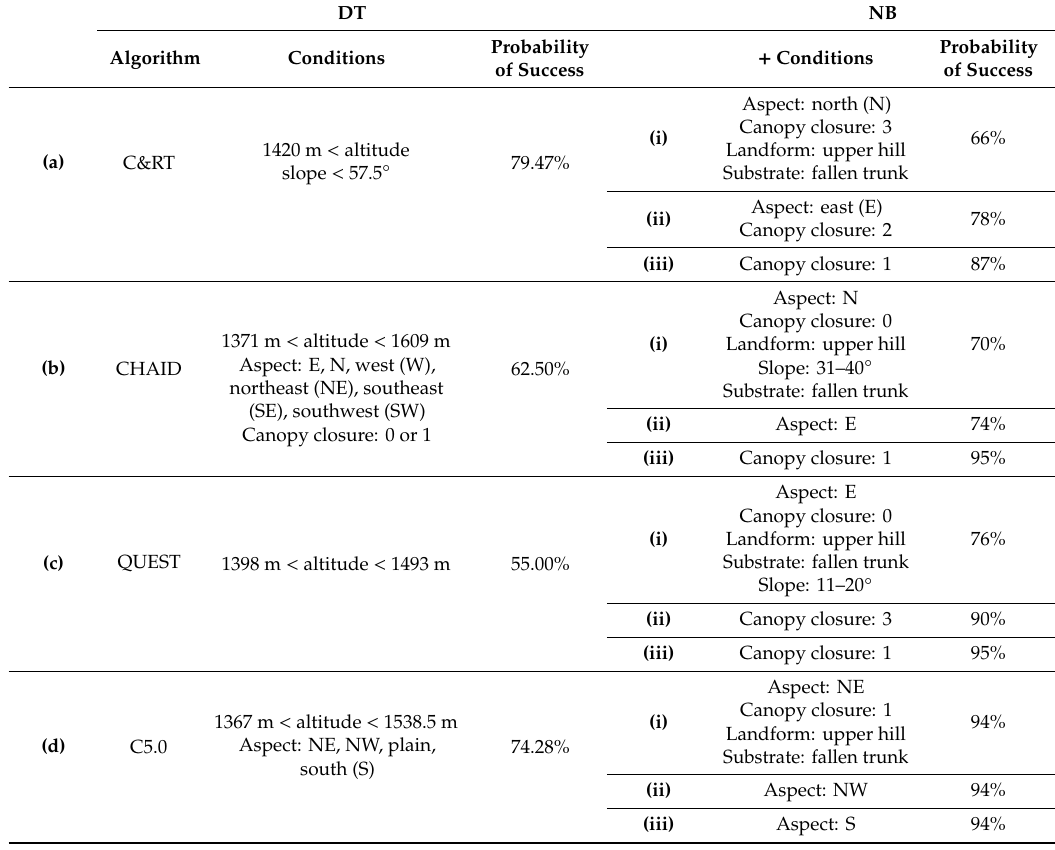
Table 3. Examples of transplantation success predictions by decision tree and naïve Bayes methods. For each DT algorithm, there are NB conditions corresponding and adding to it. The cells tagged as ( ii ) and ( iii ) in the NB part show how probability changes after a minor change in the ( i ) cell. DT